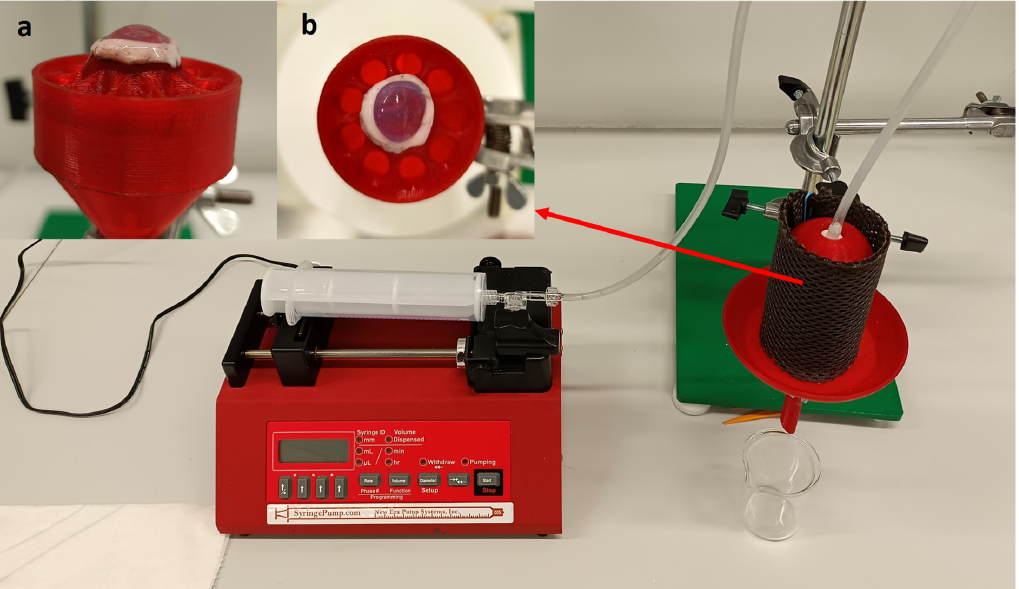
Figure 11. Actual view of the apparatus prepared for the drug release experiment, equipped with a syringe pump. The brown fabric wrapped around the sample chamber is soaked with water to maintain moisture around the carrier and cornea. The insets show the cornea and collagen drug carrier placed in the holder ( a ) side view and ( b ) top view. Both the fluid collected during the experiment and the corneal leachate were ana ‐ lyzed with UV ‐ Vis spectrometry using the 1 mm ‐ path cuvette. Obtained concentration values were recalculated to reflect the released amounts of API in question. The experi ‐ ments were done in triplicate. Calibration curves of both API and representative absorp ‐ tion spectra are in Supplementary Information in Figures S2–S5.